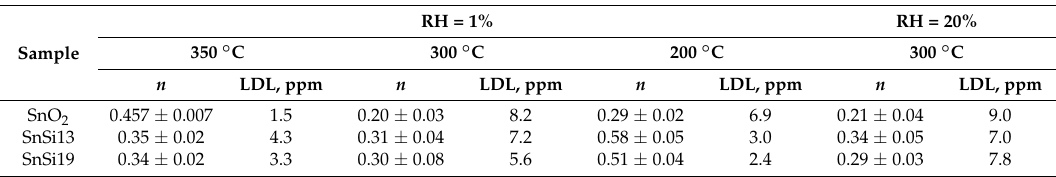
Table 2. CO detection limit (LDL) for SnO 2 , SnSi13 and SnSi19 samples, as well as the power coefficients ( n ) calculated from obtained calibration